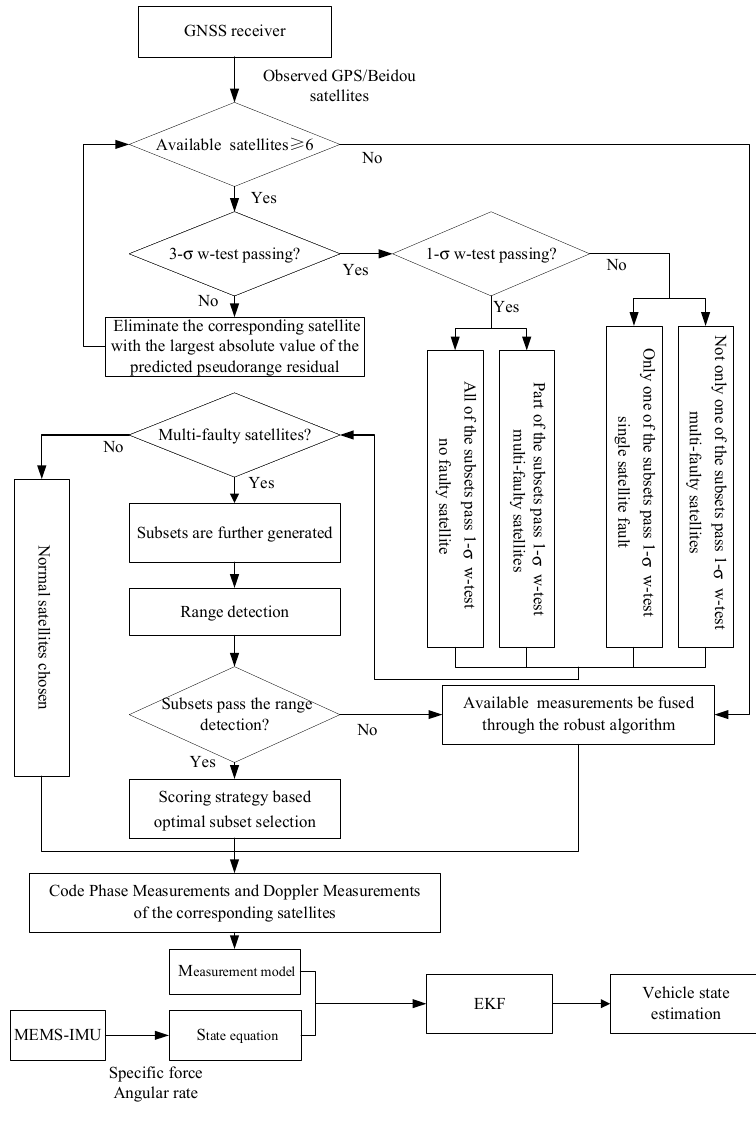
Figure 1. System